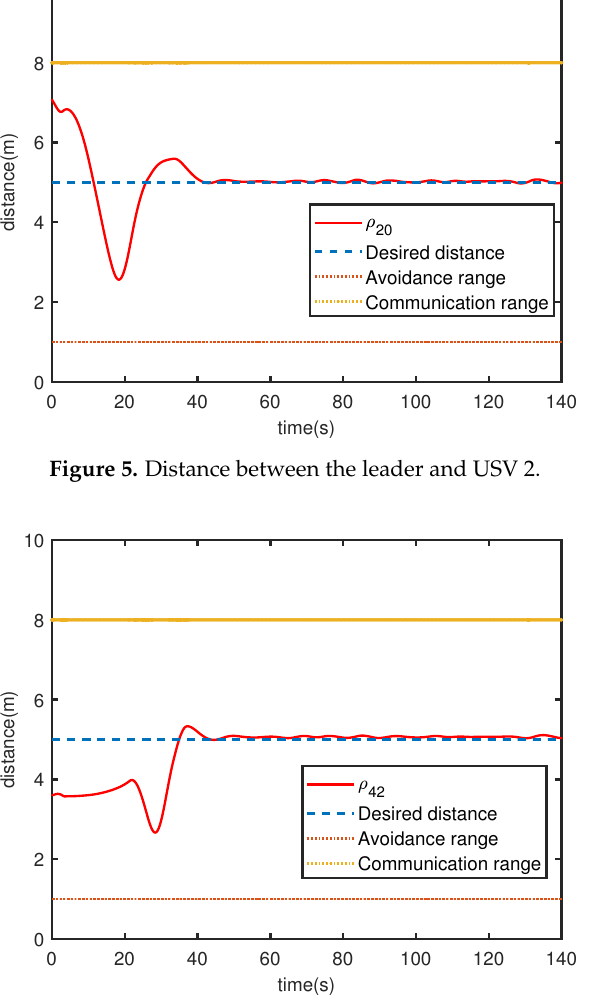
Figure 6. Distance between USV 2 and USV